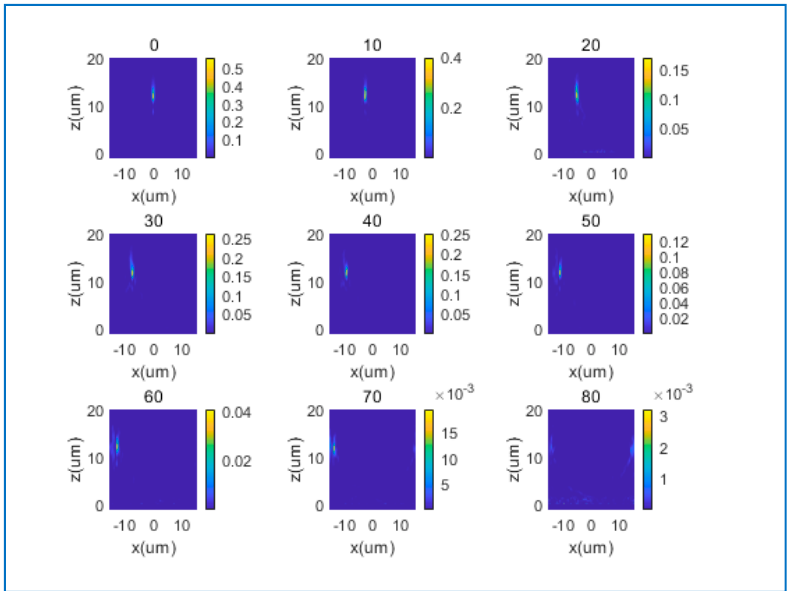
Figure A3. Focal profile of light with incident angles from 0° to 80°, which is reflected by the meta-reflector with Au film as bottom mirror in Figure 5a.